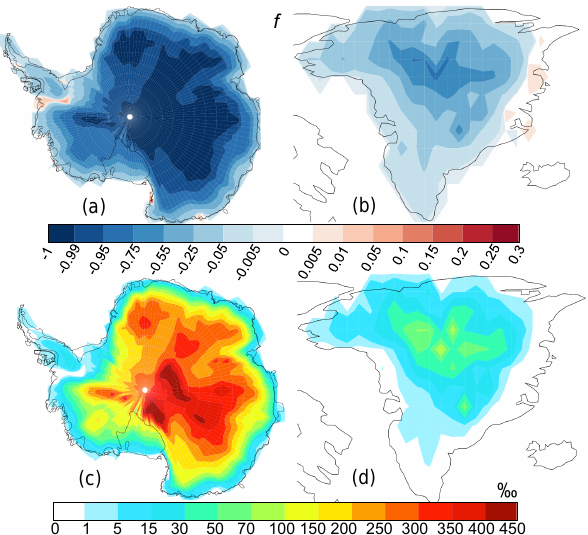
gained (positive values) or lost 3 ) (Eq. 14) due 3 in snow. Note the varied color bar 3